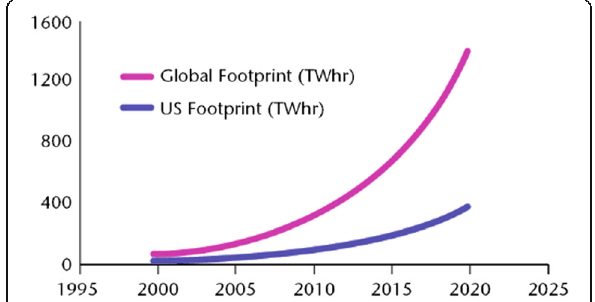
Fig. 1 Projection of data centres electricity